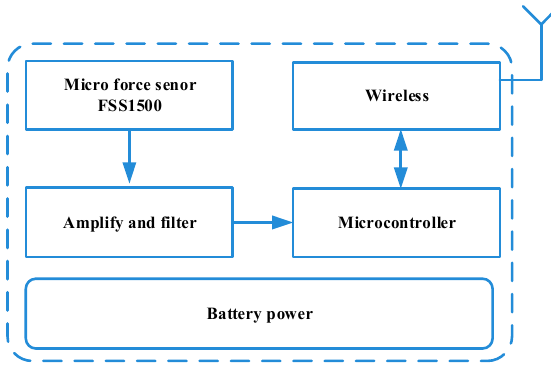
Figure 5. Robotic grasp force detection system.